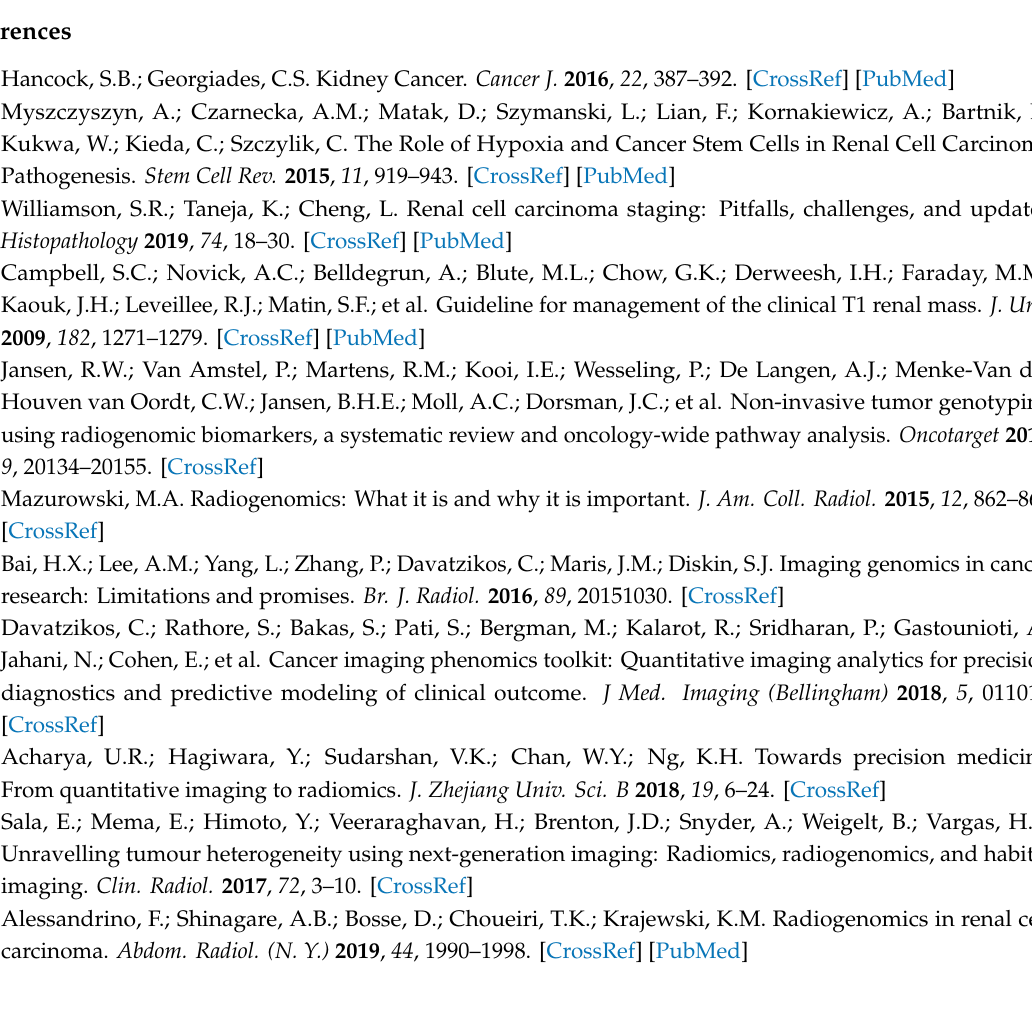
Table S1: Patient demographics and clinical information, Table S2: Patient demographics and clinical information in the radiomics validation cohort, Table S3: Trait-associated gene list, Table S4: List of genes using in geneset enrichment analysis, Table S5: Pathway enrichment of trait-associated genes, Table S6: Survival significance of genes in pathways, Table S7: Gene-set enrichment scores and inferred relative proportion of immune cell types of TCGA-KIRC RNA-seq gene expression